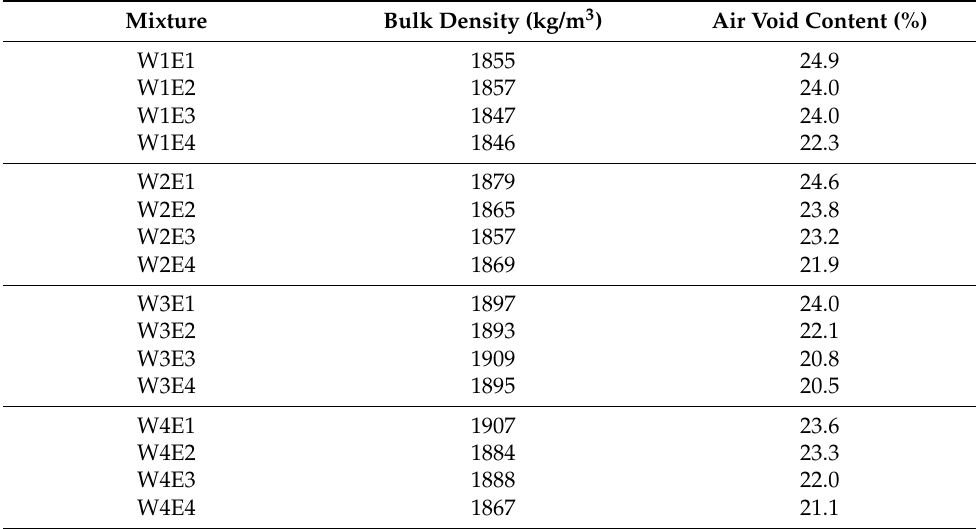
Table 4. Bulk density and air void content for mixtures by the modified Proctor